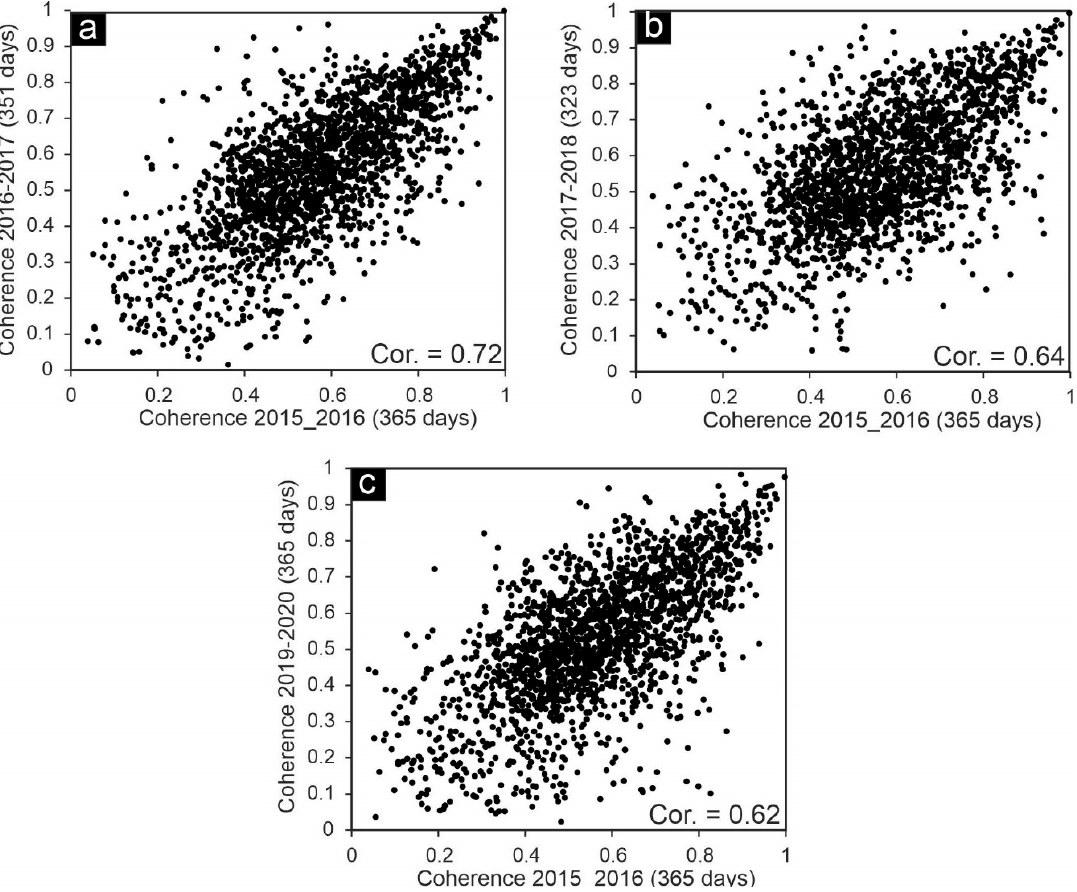
Figure 6. Scatter plots and correlation coefficients of ( a ) time span 1 (2015–2016) against time span